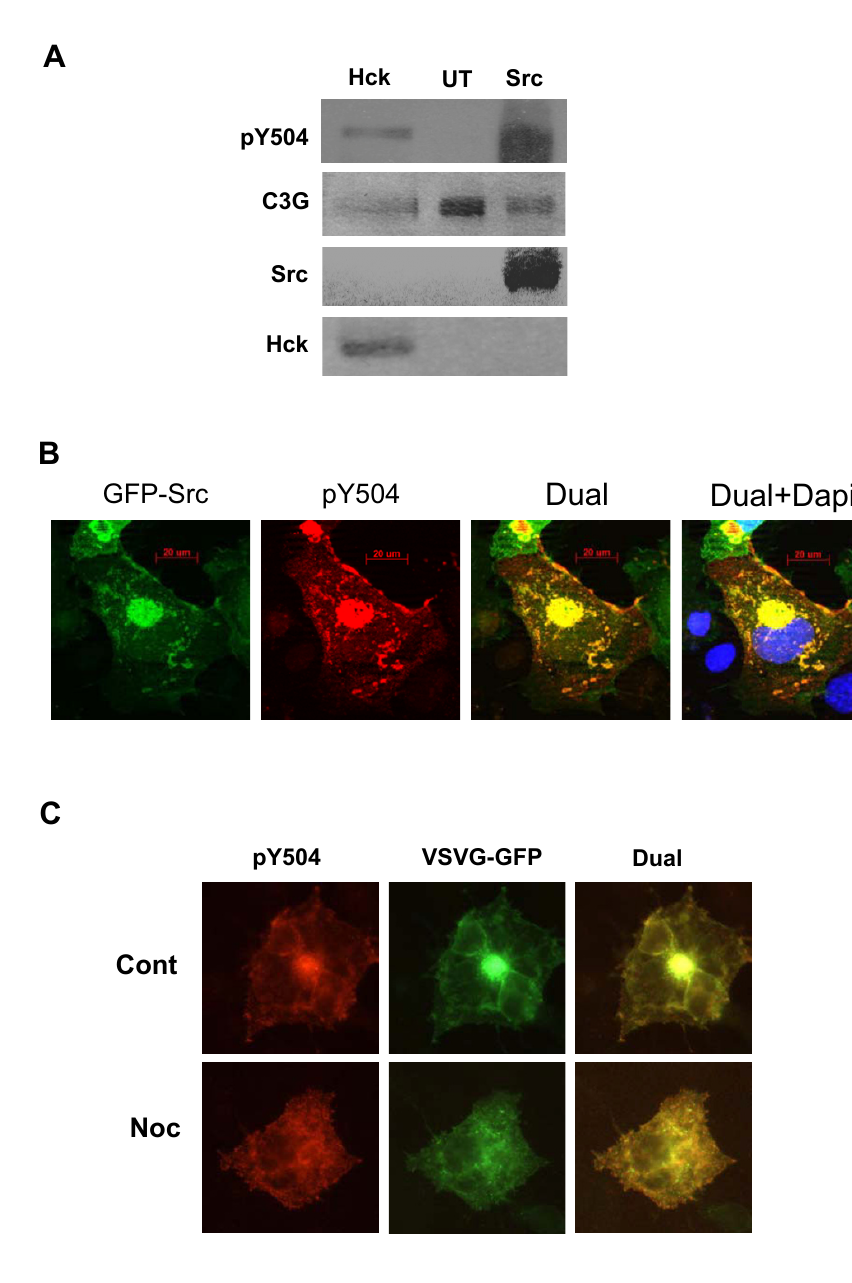
Figure 4 Phosphorylation of endogenous C3G upon overexpression of Hck and its localization to the Golgi. (A) Cos-1 cells were transfected with expression constructs as indicated and whole cell lysates used in western blotting for pY504-C3G. ECL was used for detection. Blots were reprobed to show expression of C3G and the kinases. (B) Endogenous pY504 C3G colocalizes with c-Src. Cos-1 cells were transfected with the c-Src GFP fusion protein vector and cells stained for pY504-C3G expression (Cy3). c-Src expression was visualized as GFP fluorescence. Images shown are optical sections taken using the apotome. (C) Endogenous pY504-C3G localizes to the Golgi. Cos-1 cells were transfected with Hck along with VSVG-GFP and stained for pY504 C3G. Cells were left untreated (control) or treated with nocodazole (Noc) prior to fixation as described in Methods. Panels show optical section for pY504 by Cy3 and the VSVG-GFP by GFP